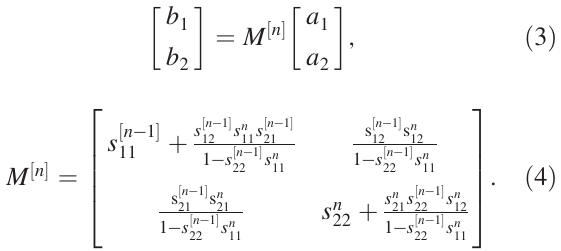
FIG. 2. (a) Scheme and (b) network of pulse compressor with a storage cavity and n correction cavities. The arrows in green represent the rf power flow, which goes through the cavities one by one. The small ones are correction cavities, being of relatively low unloaded quality factor (Q-factor) and small size. The large one is the storage cavity with a large unloaded Q-factor, thereby offering the high efficiency of the pulse compression system. M n is the S-matrix of the n th cavity, and M ½ n (cid:2) is the S-matrix of the cavity chain with n cavities. The input waves of the M ½ n (cid:2) are a 1 and a 2 , and the output waves are b 1 and b 2 . The input waves of the M n are a 1 m and a 2 , and the output waves are b 1 m and b 2 .